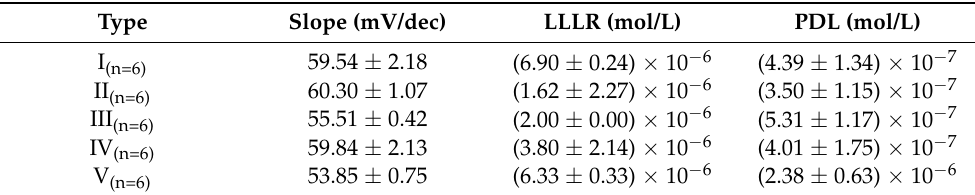
Table 2. Potentiometric working characteristics for the atropine-selective